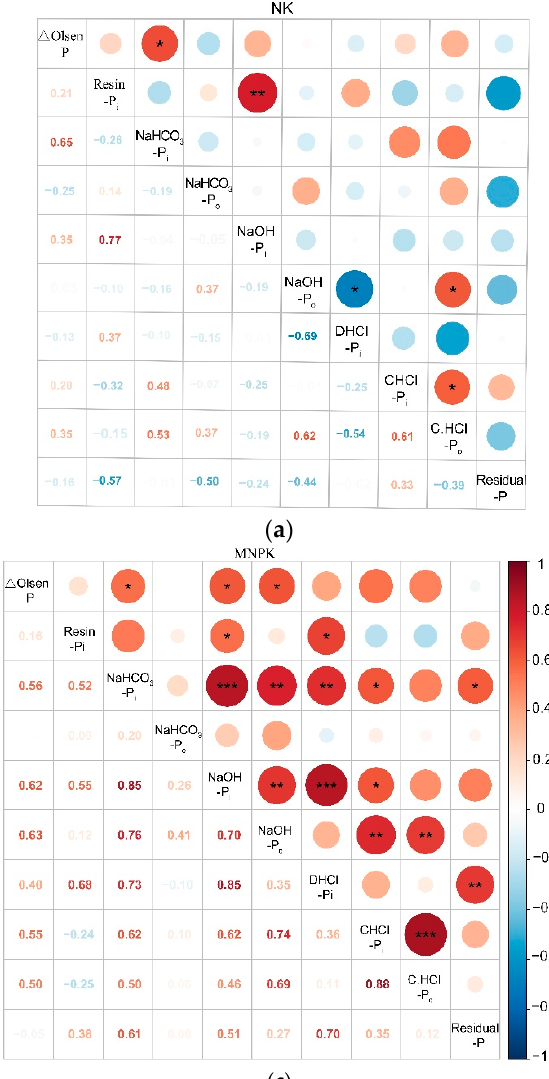
Figure 4. Correlation analysis between Δ Olsen P and P fractions. NK, nitrogen and potassium; NPK, nitrogen, phosphorus and potassium; MNPK, manure, nitrogen, phosphorus and potassium. The red indicates positive correlation, the blue indicates negative correlation, the circle is large and dark, the correlation is strong. The * in the circle indicates significant correlation, and the value on the left of the figure indicates R 2 . *, p < 0.05, **, p < 0.01, ***, p < 0.001. a: NK treatment, b: NPK treatment, c: MNPK treatment.